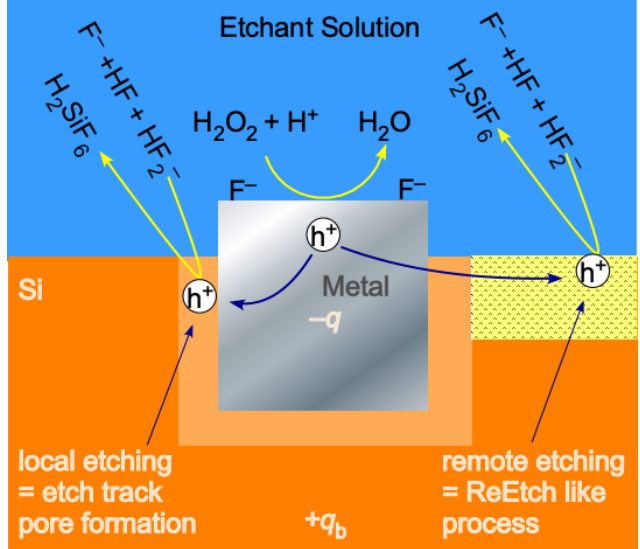
Figure 2. Hole are generated by the decomposition of H 2 O 2 catalyzed by reaction on the surface of metal nanoparticles. Holes trapped at the metal/semiconductor interface initiate local etching and etch track pore formation. Holes that escape the space charge layer initiate remote etching which generates tortuous pores similar to those generated by ReEtching.